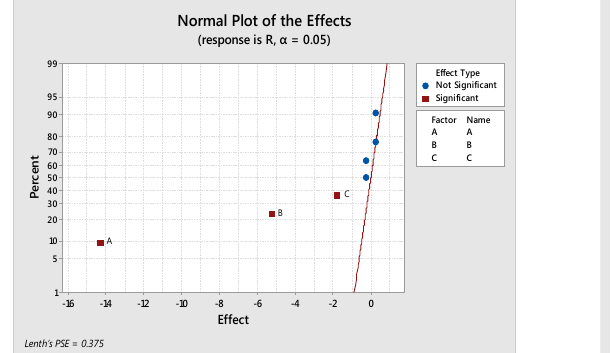
Fig. 11. The main effects plot for showing the impact of levels of input parameters